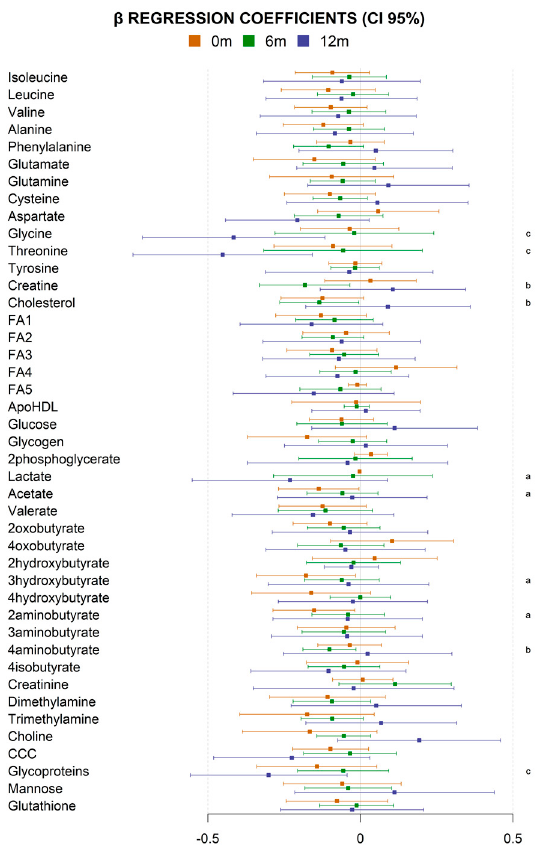
Figure 1. Linear association between maternal weight gain and metabolite levels. Linear regression beta coefficients and 95% confidence intervals (CI) for the association at birth (orange), 6 months of age (green), and 12 months of age (blue) between maternal weight gain and individual child serum metabolites adjusted for child sex, child weight at birth, maternal obesity, maternal diabetes, and maternal adherence to the Mediterranean diet. Each square represents the beta coefficient for a single metabolite, and the horizontal line indicates the 95% CI. Positive beta coefficients indicate a positive association with the outcome, while negative beta coefficients indicate a negative association. Metabolites with a statistically significant association (adjusted p value < 0.05) are marked as “a” (birth), “b” (6 months of age), and/or “c” (12 months of age). Label keys: CCC, choline-containing compounds; FA1, CH3 groups in fatty acids; FA2, beta CH2 groups in all, saturated and unsaturated, fatty acids; FA3, =CH 2 -CH 2 -CH 2 -CH= in fatty acids; FA4, =CH-CH 2 -CH= in fatty acids; FA5, all -CH=CH- in fatty acids; ApoHDL, apolipoproteins in HDL lipoparticles.